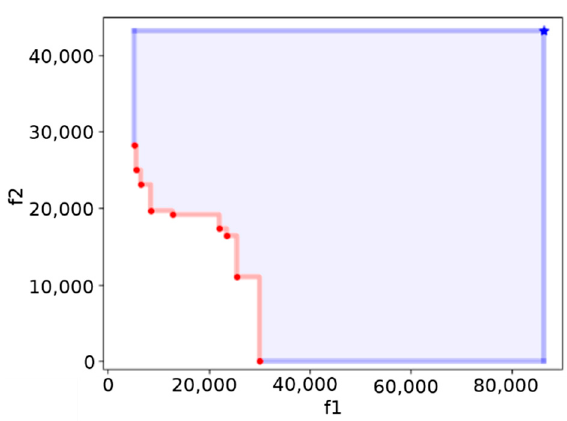
Figure 6. An example of Pareto frontier, with the associated hypervolume, for two minimization objectives ( 𝑓 (cid:2869) is the detection time and 𝑓 (cid:2870) is its standard